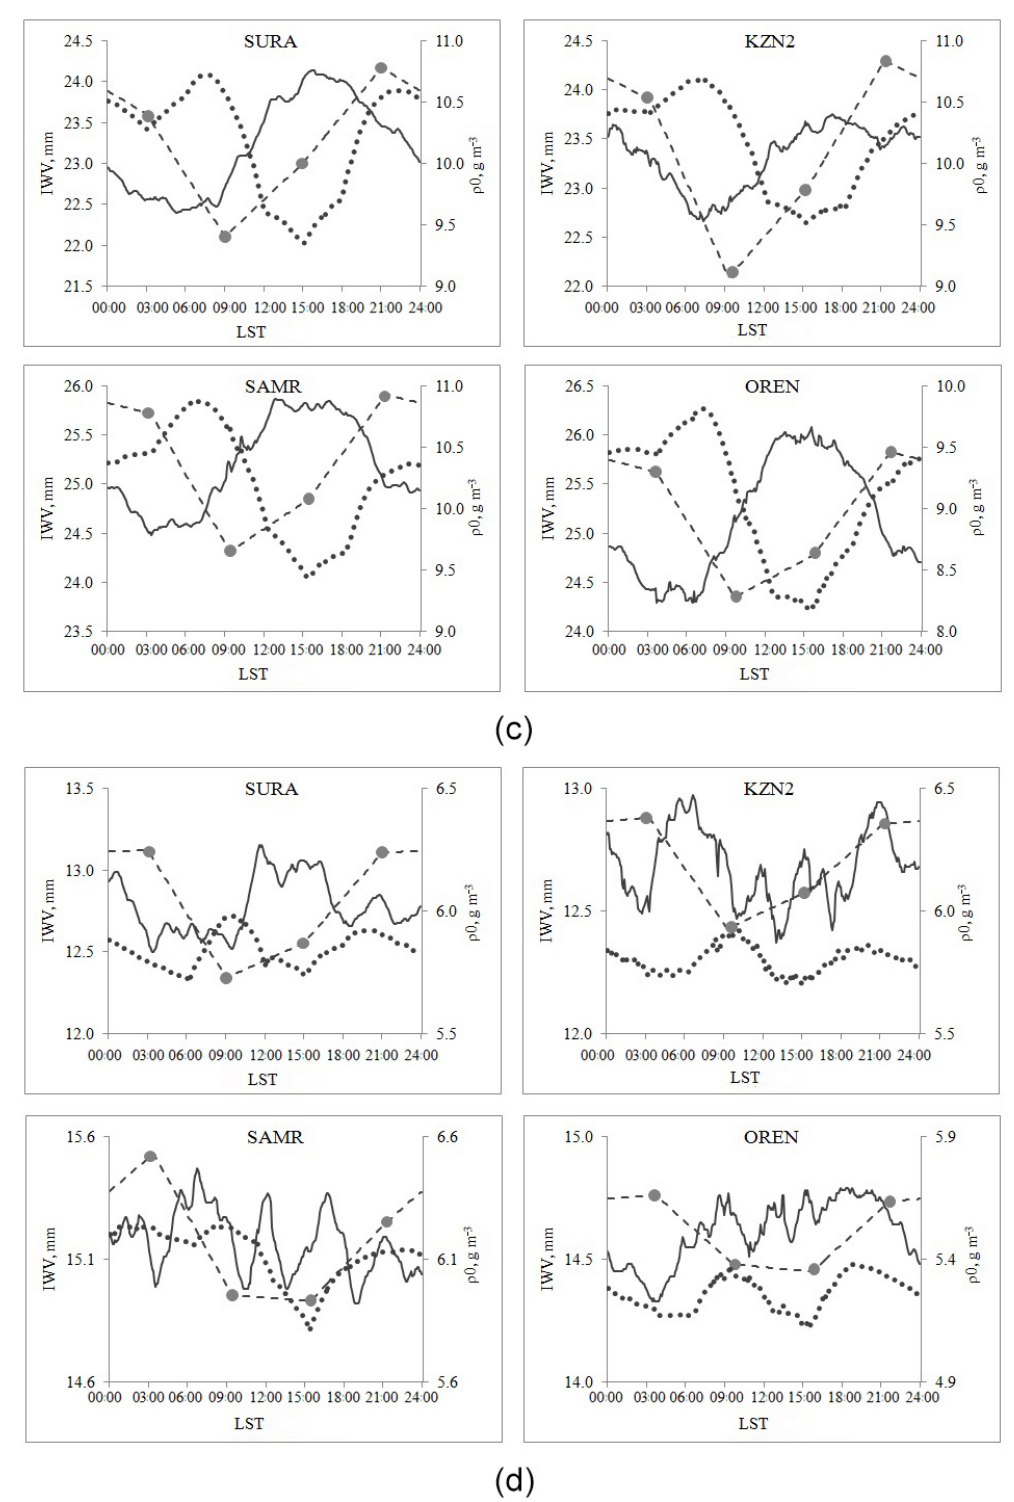
Figure 1. Mean diurnal variations in surface water vapor density ρ 0 (dotted curve), IWV from GPS (solid curve) and ERA-Interim (dashed curve) data at four GPS stations for winter (a) , spring (b) , summer (c) and autumn (d)